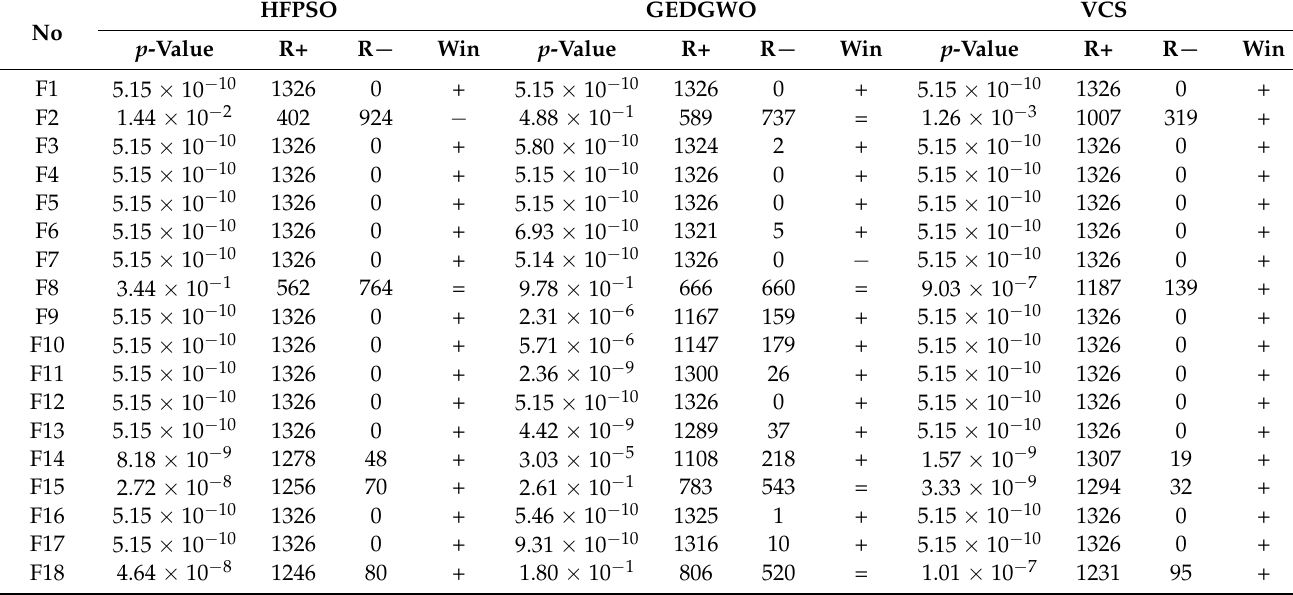
Table A2. Wilcoxon signed-rank test results ( α =